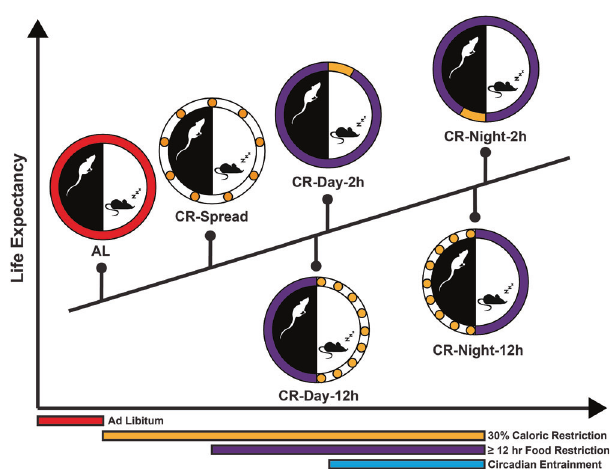
Fig. 1 Impacts of diet regimens on life expectancy. Five different CR feeding paradigms were designed to assess their bene fi cial effect on longevity. Male C57BL/6J mice were subjected to the AL diet for the fi rst six weeks and then switched to a 30% CR puri fi ed diet for the rest of their life. Compared with ad libitum feeding, controlling daily calorie intake solely can improve the median lifespans by about 10%. Feeding CR diet to animals restrictedly in a 2-hour or 12-hour period during the day and minimally fasting animals for 12 h daily further extend median lifespans by another 10%. However, the most signi fi cant promotion of longevity was observed when combining CR with > 12-hour fasting interval and nocturnal feeding. Entraining circadian rhythm with the nocturnal feeding and diurnal fasting cycle can ultimately increase lifespans by about 35% in animals. AL Ad libitum, CR Caloric